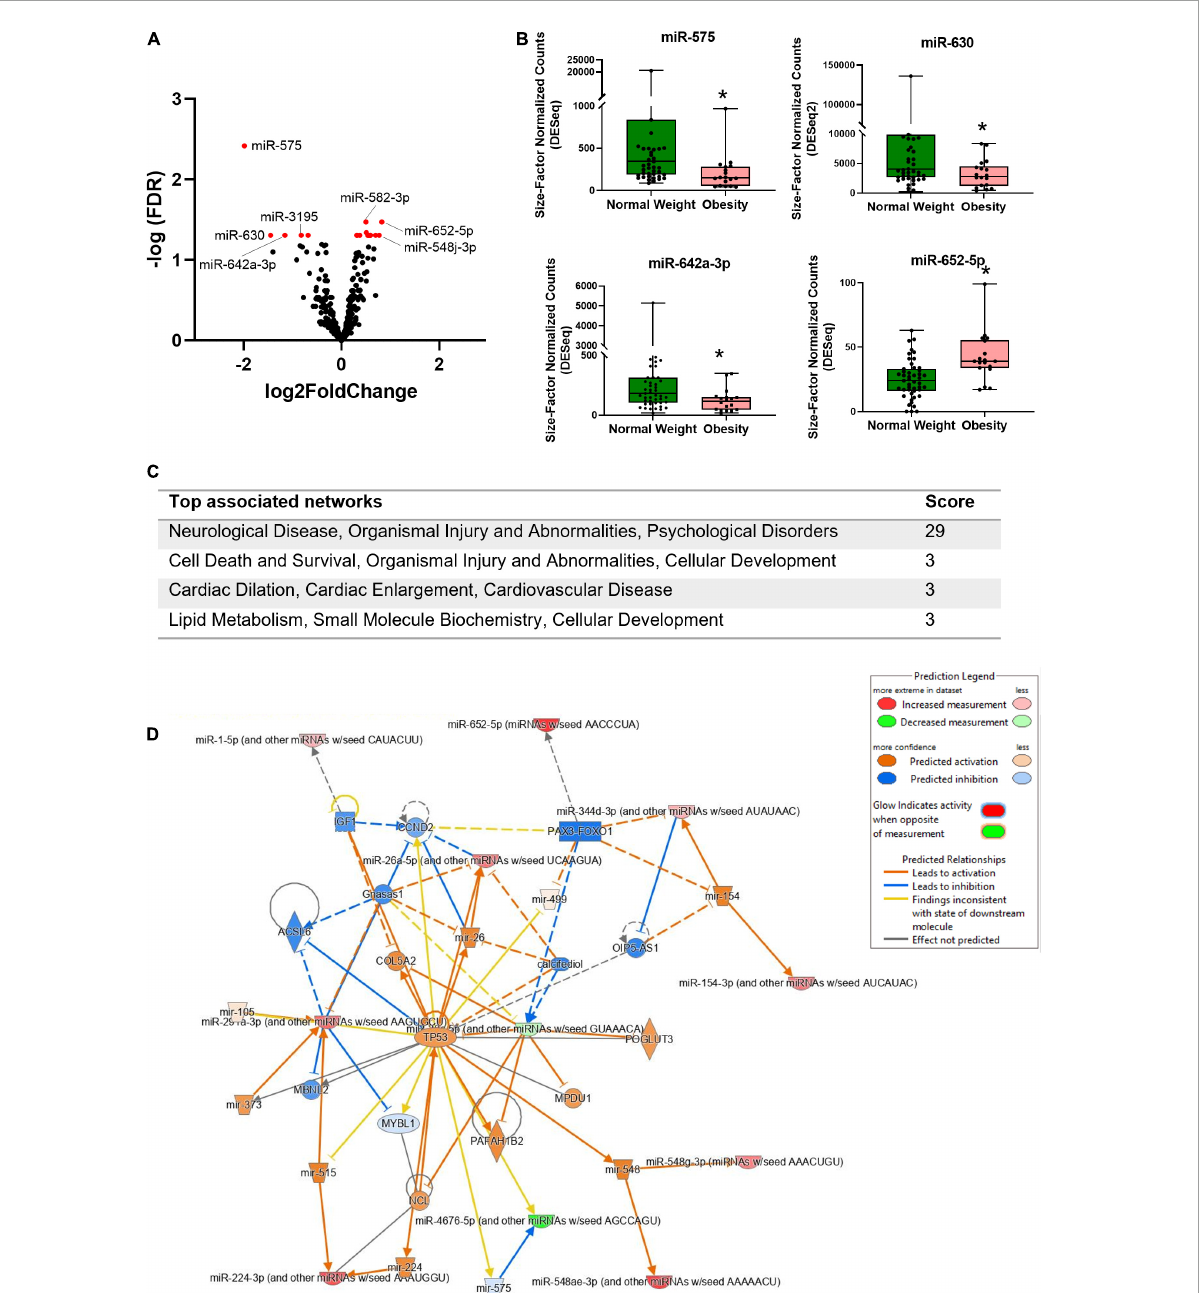
FIGURE3 Differentially expressed miRNAs in bEVs of mothers with obesity. (A) Volcano plot shows the distribution of miRNAs in bEVs with fold changes and p values. miRNAs in red represent deregulated miRNAs with a cut-off of adjusted p < 0.05. (B) Normalized counts of selected miRNAs are shown between groups. *Represents a statistical significance with adjusted p values < 0.05. (C) Top associated networks are analyzed using differentially expressed miRNAs and their predicted target genes in bEVs of mothers with obesity. (D) The network is the #1 network in panel (C) ; neurological disease, organismal injury and abnormalities, and psychological disorders. TP53 is a hub gene of this